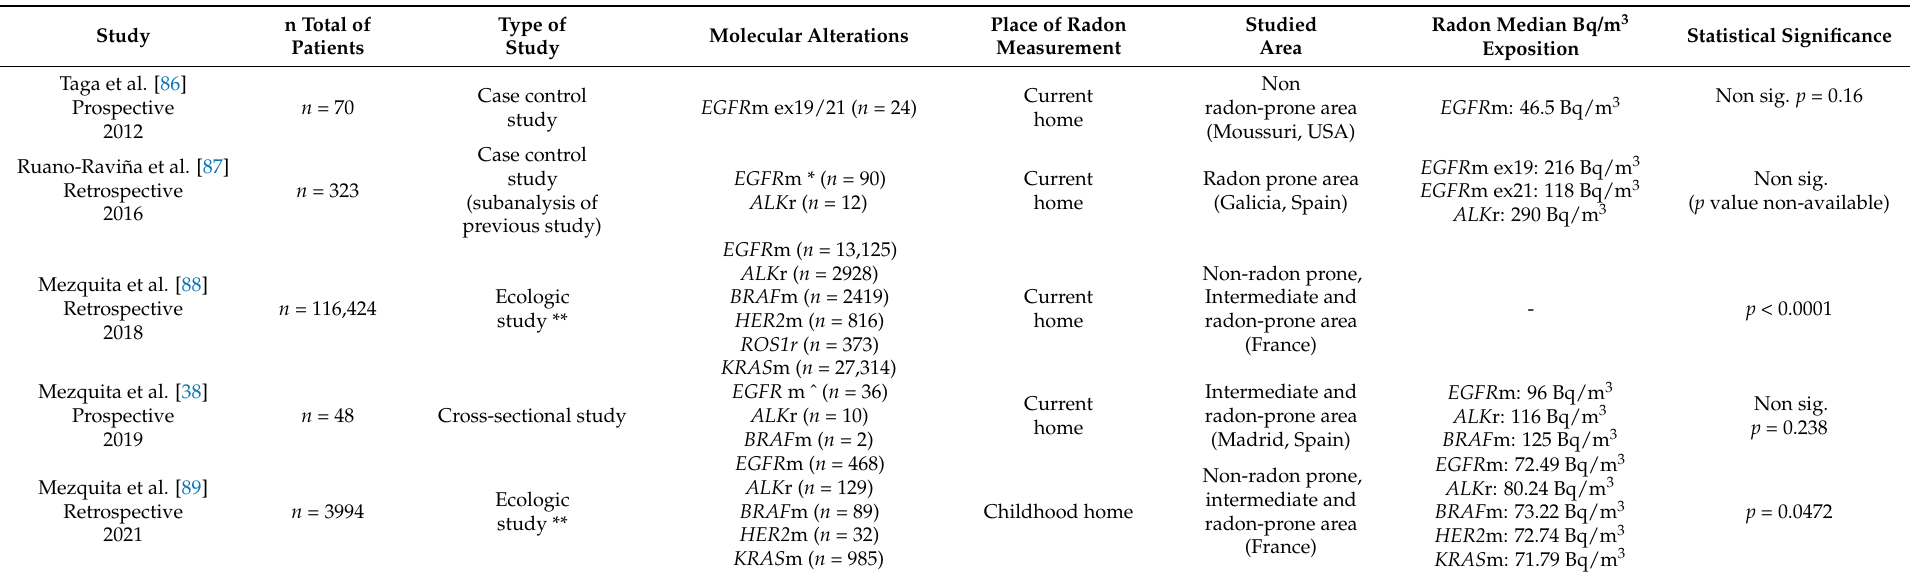
Table 1. Studies reported on the indoor radon concentration and molecular alterations in NSCLC